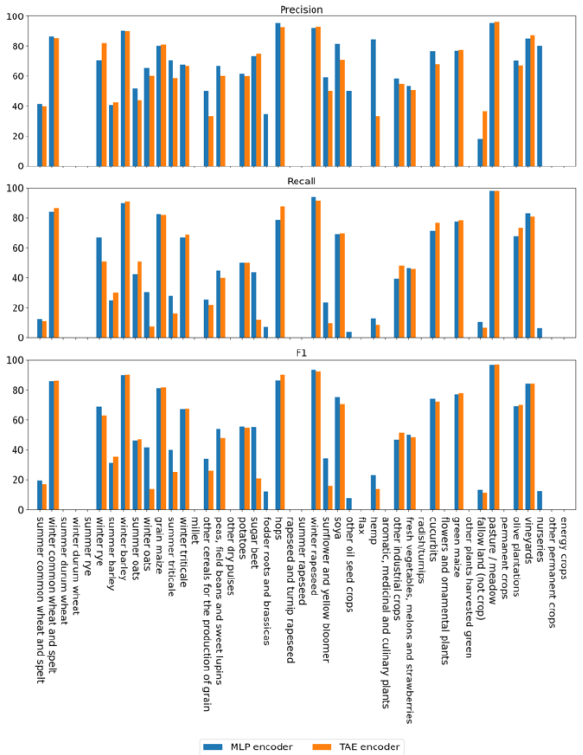
Figure 5. Class-specific scores (precision, recall, F1) obtained with LSTM (blue) and Transformer classifier (orange).